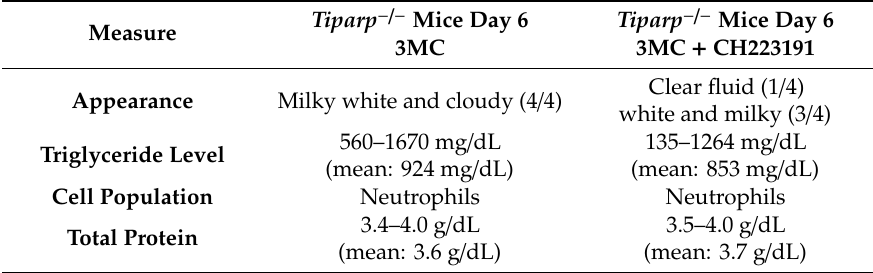
Figure 8. Cotreatment with CH223191 reduced 3MC-induced alanine aminotransferase (ALT) activity and epididymal adipose tissue loss. WT or Tiparp − / − mice were cotreated with 100 mg / kg 3MC on day 1 and with 10 mg / kg CH223191 (CH) on days 1 and 3. ( A ) Hepatic Cyp1b1 mRNA expression levels. ( B ) ALT activity levels on day 3. ( C ) WAT weight was expressed as a percentage of total body weight on day 6. Data represent the mean ± SEM. a p < 0.05 two-way ANOVA comparison between ( A ) genotype-matched corn oil- and 3MC-treated mice, ( B ) genotype-matched day 0 and 3MC-treated day 3 mice, and ( C ) treatment-matched WT and Tiparp − / − mice on day 6. b p < 0.05 two-way ANOVA comparison between WT and Tiparp − / − mice treated with 3MC and 3MC + CH followed by a Tukey’s post hoc test. Table 2. Characteristics of ascites observed after 3MC and CH223191 cotreatment compared to 3MC alone in Tiparp − / − mice. Values in parentheses indicate the number of observations over the number of total observations.